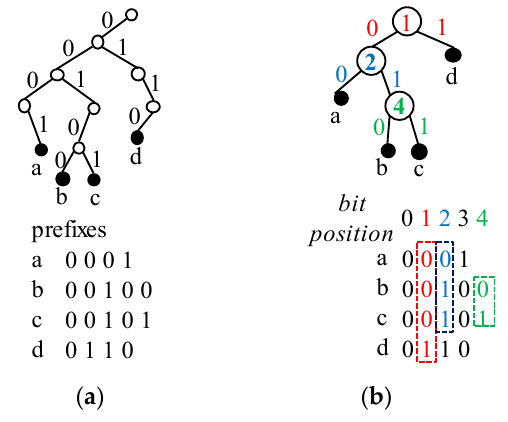
Figure 3. Two trie structures to contain four prefixes: ( a ) binary trie and ( b ) Patricia trie.